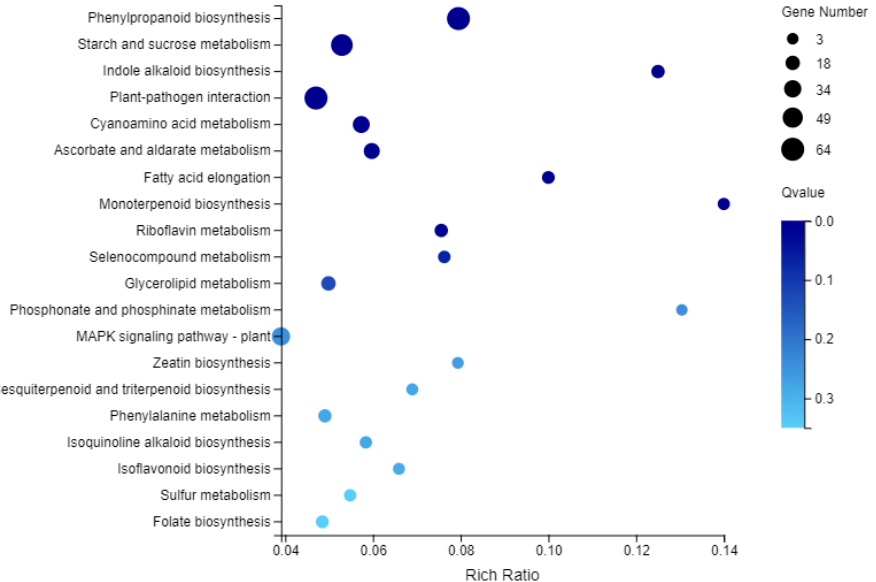
Figure 9. A bubble plot of KEGG pathway enrichment of DEGs showing the top 20 enriched pathways. The size of dots represents the number of genes. MAPK, mitogen-activated protein